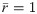
Stability and feasibility: Outline.(a) For a system to be feasible, interaction strength has to decrease with complexity. The Y-axis represents an interaction-strength normalizing factor that defines three regimes depending on the parameter δ: strong interactions (δ > 0.5), moderate interactions (δ = 0.5; blue line, with C = 0.4), and weak interactions (0 ≤ δ < 0.5). (b, c, d) For the three regimes, the graphs show the eigenvalues of the Jacobian J(x*) for 100 realisations of May’s random model (S = 150, θ = −1, σ = 0.4). Eigenvalues with a real part larger than 0 are unstable; eigenvalues of feasible systems are in blue. (b) With strong interactions, equilibria are never feasible nor stable. (c) With moderate interactions, feasible equilibria are stable. (d) With weak interactions, all equilibria are feasible and May’s stability criterion is trivially fulfilled. (e, f, g) Probability of feasibility for the three regimes: null under strong interactions; decreasing under moderate interactions; null or one under weak interactions. (h) In the weak regime, the probability of feasibility depends on the parameter values, for example the mean interaction strength (μA) and minimal growth rates (Min(ri)). The panel shows the result of Theorem S.3.6 for θ = −1 and r¯=1. Blue region: parameters values leading to feasible equilibria (in red, to unfeasible equilibria). Note the trade-off between μA and Min(ri). (i, j) Under weak interactions, unstructured networks and the cascade model lead to deterministic abundances at equilibrium (in our setting, prey, predator, and intermediate species reach equal abundances). Interestingly, in structured networks (as the niche and the nested-hierarchy model), the abundances at equilibrium remain random, with a support depending on the trophic position of the species in the web.